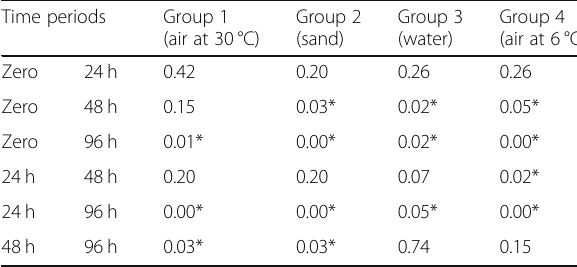
Table 5 Pairwise comparisons for each time point of the heart GAPDH level in the four studied groups Time periods